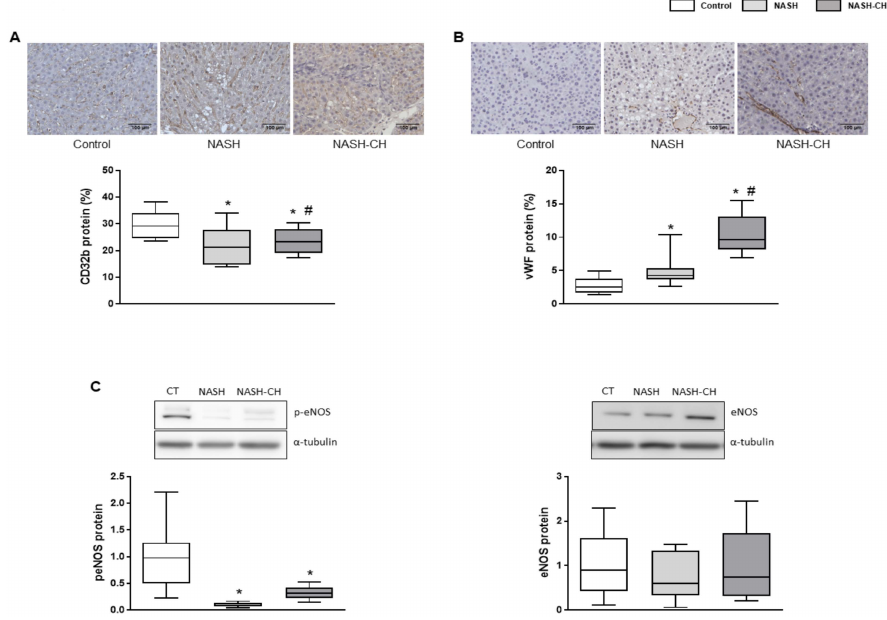
Figure 5. LSEC phenotype in control and NASH rats. ( A ) Representative images of CD32b immunohistochemistry in liver tissue and its quantification. ( B ) Representative images of vWF immunohistochemistry in liver tissue and its quantification. ( C ) p-eNOS and eNOS protein expression in total liver tissue, normalized to α -tubulin. Results represent mean ± SEM, * p < 0.05 vs. control group, # p < 0.05 vs. NASH group ( n = 6 rats per group). All images scale bar = 100 µ m.